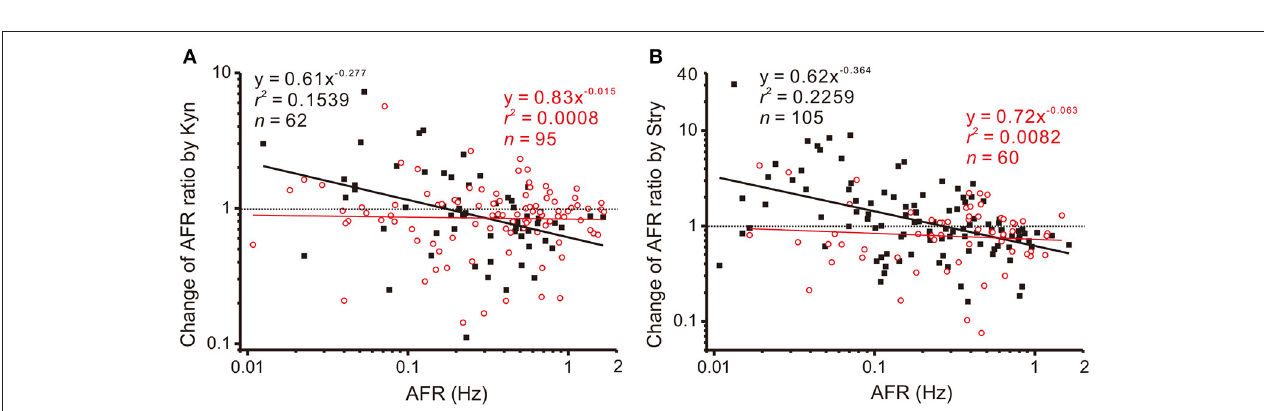
FIGURE 6 | L-NAME pretreatments eliminate Kyn- or Stry-induced plFM. For comparisons, the data in Figure 4 obtained from Kyn or Stry applications without L-NAME pretreatment were replotted here, shown as the solid black squares and the thick black regressed line. Empty red circles and the thin red regression line show the data with L-NAME pretreatments. The data with L-NAME pretreatment were not successfully regressed by the power functions ( P = 0.7868 and 0.4952 in A,B , respectively). Slopes of the regression lines derived from the data with and without L-NAME pretreatments were significantly different ( P < 0.01 in both A,B ). CI b with L-NAME pretreatments: (A) − 0.138 to 0.109 and (B) − 0.272 to 0.147.